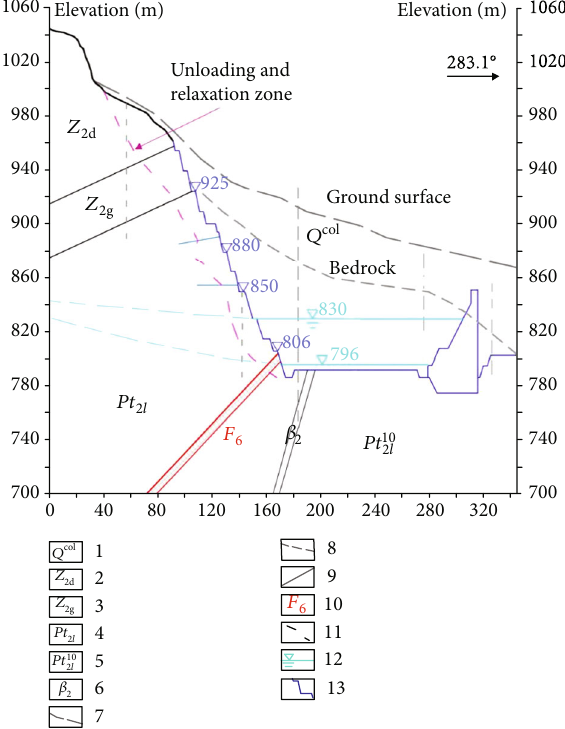
Figure 3: Engineering geology map of the slope. 1: collapse accumulation layer; 2: Dengying Formation grey to light grey thick dolomite; 3: Guanyinya group gray thin layer dolomite sandwich, ultrathin shale; 4: gray thin layer dolomite (speci fi cally refers to the falling snow group stratum in the downstream of the Huashangou fault on the left bank); 5: gray interbedded with thin limestone; 6: diabase; 7: original terrain; 8: bedrock surface; 9: lithology boundary; 10: faults and numbers; 11: lower limit of relaxation zone of arti fi cial slope; 12: groundwater level line; 13: designed excavation line.